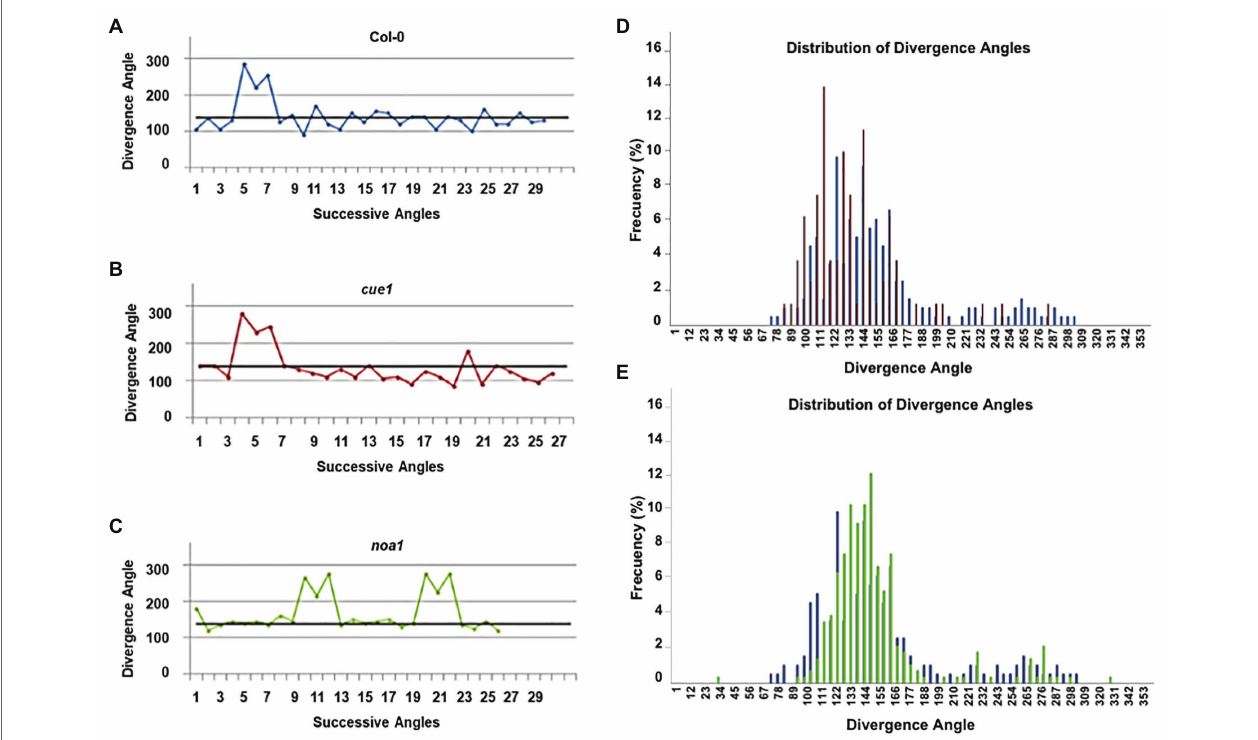
FIGURE 3 | Phyllotactic patterns of NO homeostasis mutants. Representative angle sequences of Col-0 (A) , cue1 (B) , and noa1 (C) . The black lines represent the canonical angle sequence (137.5 ° ) and colors in the graph correspond to Col-0 (blue), cue1 (red), and noa1 (green). Distribution of divergence angles for all analyzed phyllotactic sequences of Col-0 vs. cue1 (D) and Col-0 vs. noa1 (E) . At least, 10 plants per genotype were